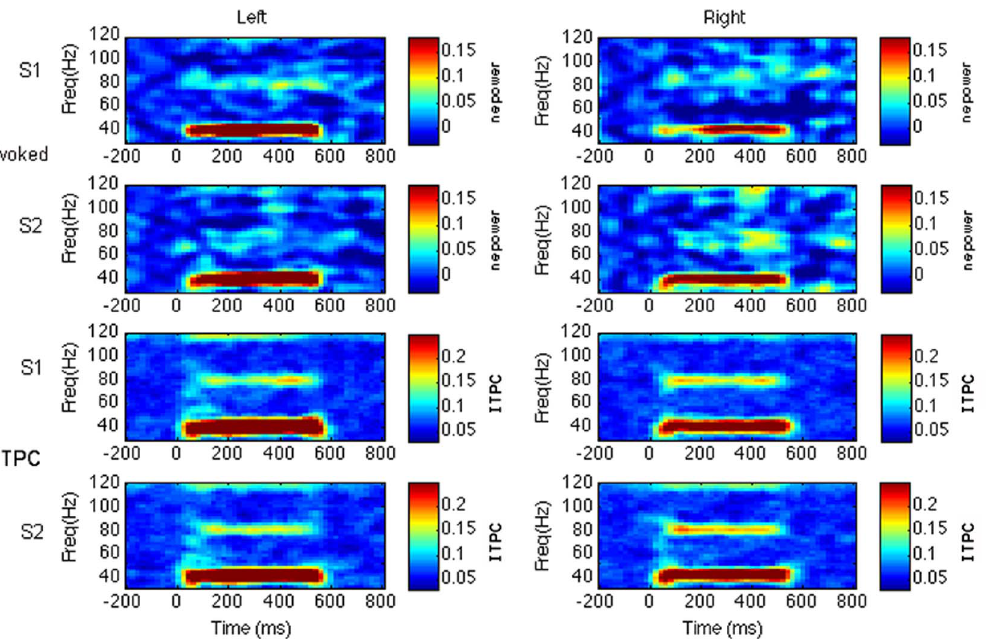
Figure 4. Example of grand averaged data. Time-frequency representations of grand-averaged evoked activity (normalized to baseline) and inter-trial phase coherence (ITPC) in response to click train stimuli for session 1 (S1) and session 2 (S2), for signal-space projected data for the left and right hemisphere. nepower = normalized evoked power.